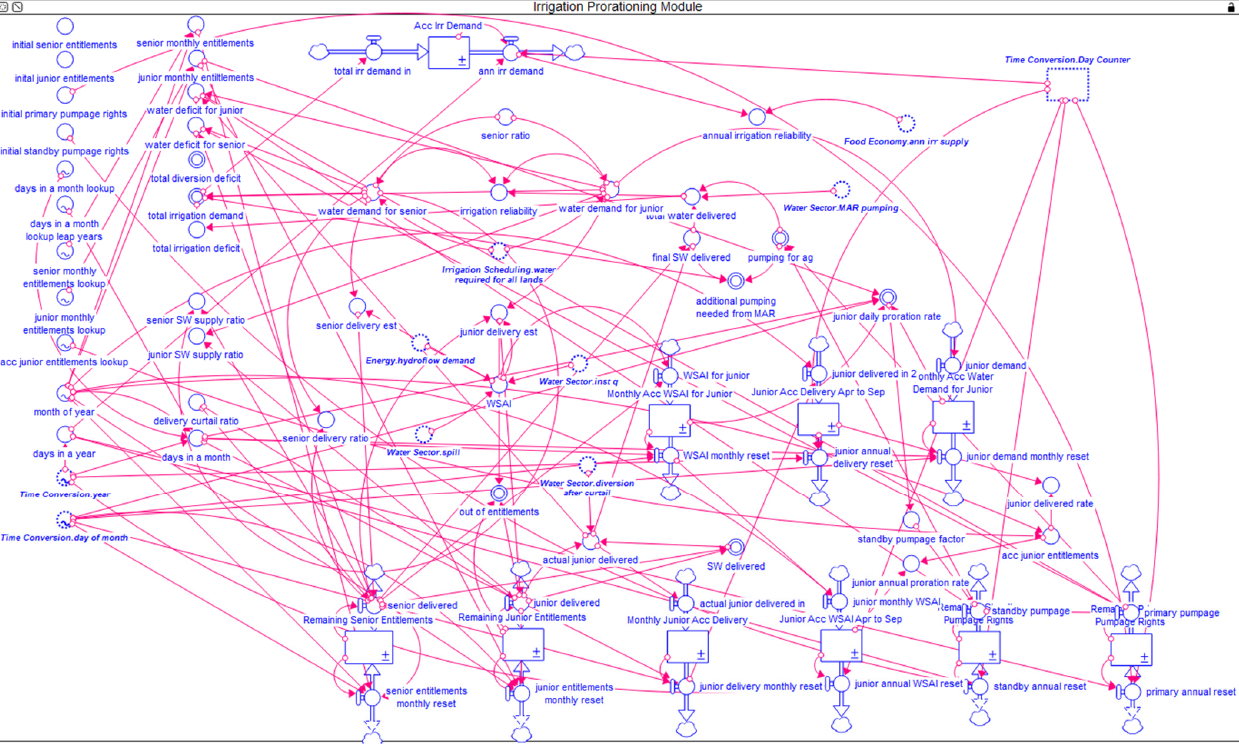
Figure A7. System dynamics model structure for irrigation prorationing based on surface water and groundwater rights.